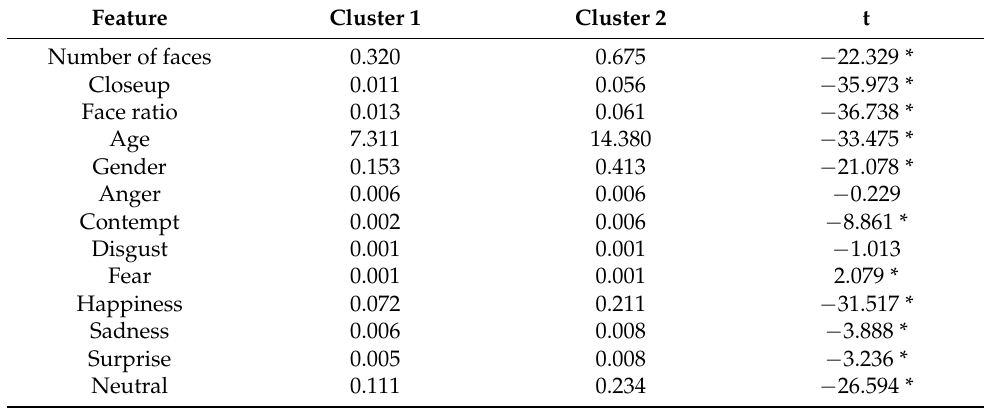
Table 2. The mean comparison of facial features between clusters of the Instagram photos with a #NoMask